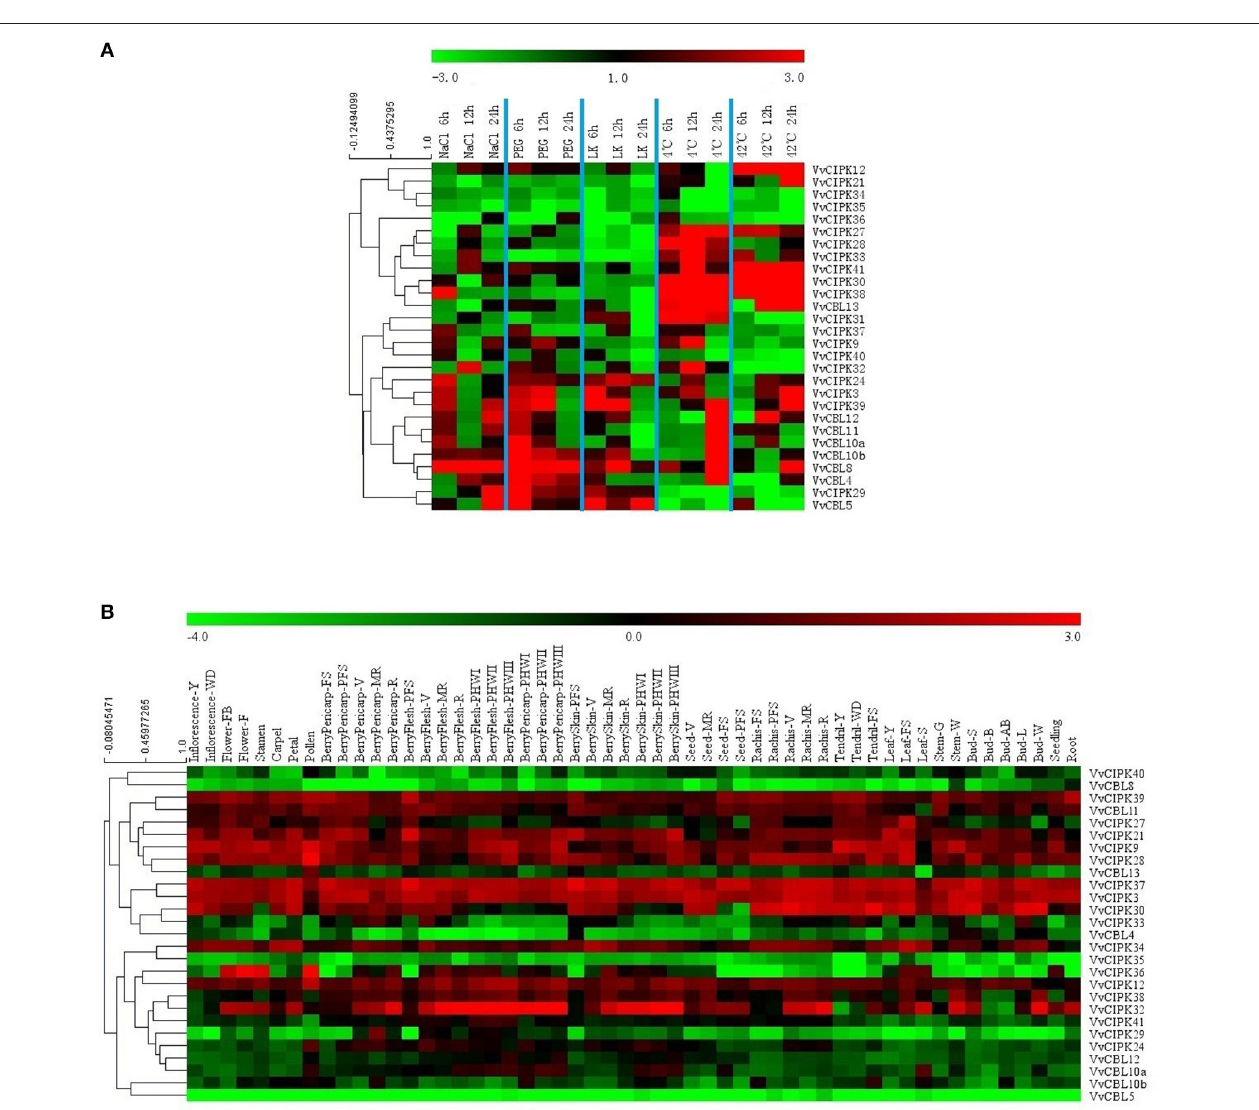
FIGURE 5 | Expression profiles of VvCBL and VvCIPK genes in response to salt, PEG, low potassium, cold, and heat (A) and in 54 different tissues and development stages based on a high-throughput transcriptome data (B) (Fasoli et al., 2012). Genes were hierarchically clustered based on the average Pearsion’s distance. Relative expression pattern of (A) were determined by qRT-PCR. Fluorescence intensities values of (B) were log 2 -based.